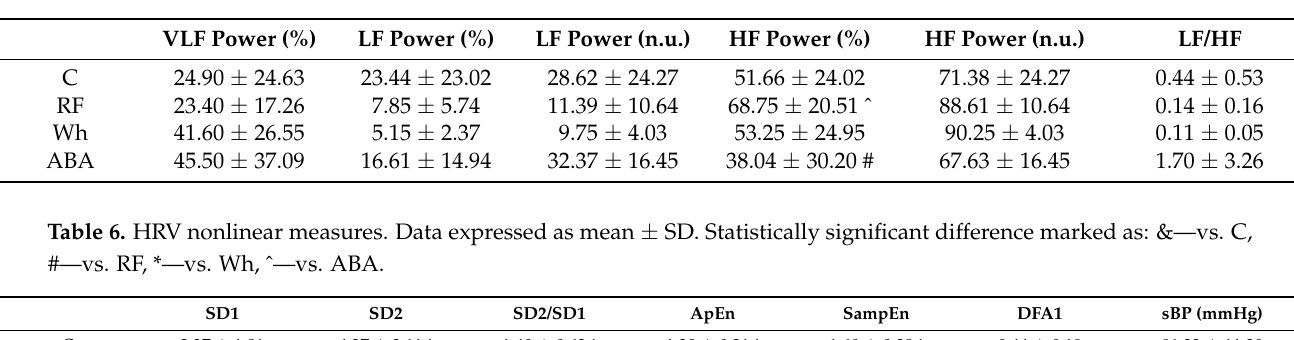
Table 5. HRV frequency-domain measures. Data expressed as mean ± SD. Statistically significant difference marked as: #—vs. RF, ˆ—vs. ABA.